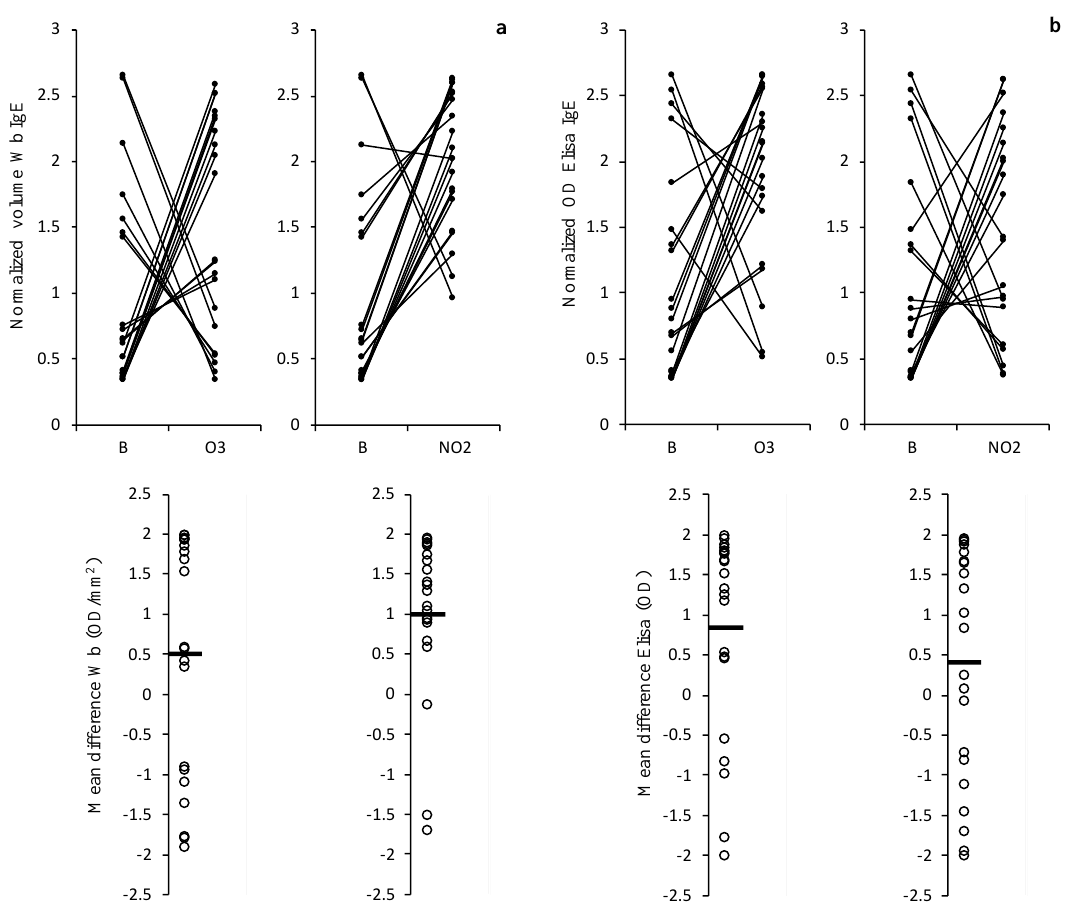
Figure 3. Results of the variation of total IgE binding normalised volume (OD/mm 2 ) in the 1D Western blot ( a ) and normalised optical density (OD) in the Elisa essay ( b ) observed between non-exposed pollen (B) and exposed to pollutants (O 3 or NO 2 ) in 21 patient sera tested. Below each graph is presented the respective mean differences in IgE reactivity (expressed in OD/mm 2 for Western blot, calculated based on each volume profile and their total area, and in OD for Elisa). The IgE values (OD/mm 2 or OD) were normalised using the z-scores method based on the total optic density of the electrophoretic profiles in the Western blot. This value was obtained by dividing the volume between each band’s area for the Western blot and the volume between the optical densities for the ELISA method. Then the z-scores method was applied. The black horizontal bar in the graphs below indicates the average mean difference.